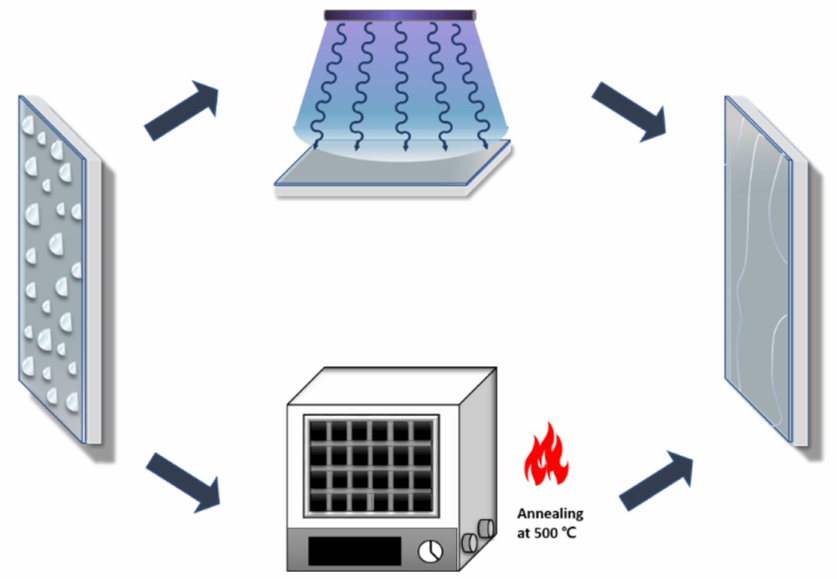
Figure 2. Schematic showing the experimental procedure for the formation of TiO 2 films with a hydrophilic surface.